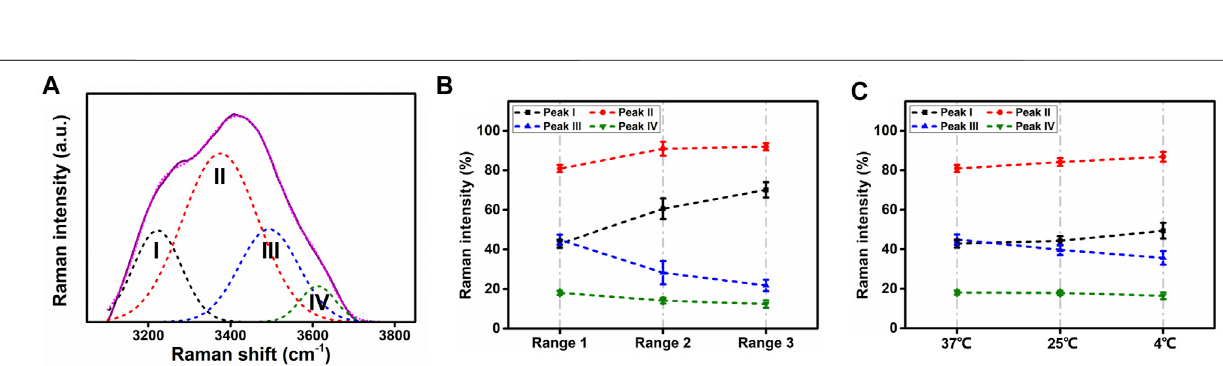
Frontiers in Chemistry |